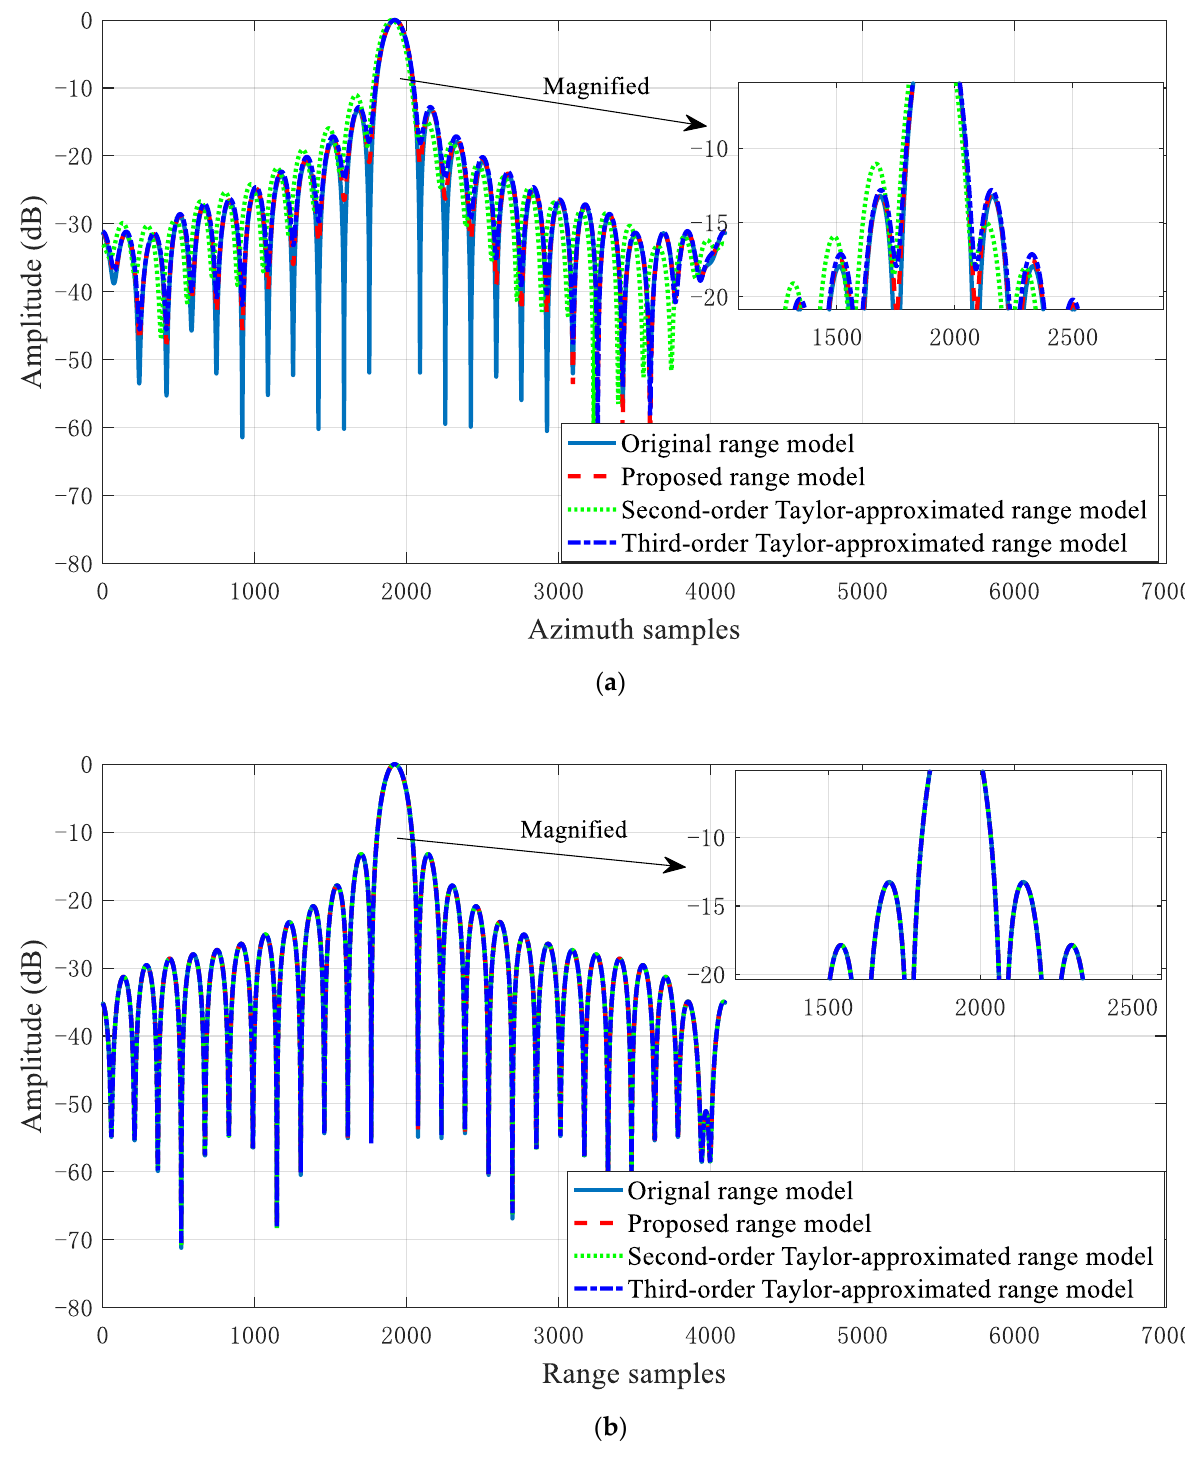
Figure 5. Focusing results. ( a ) azimuth profile, ( b ) range profile. The parameters of the target are R